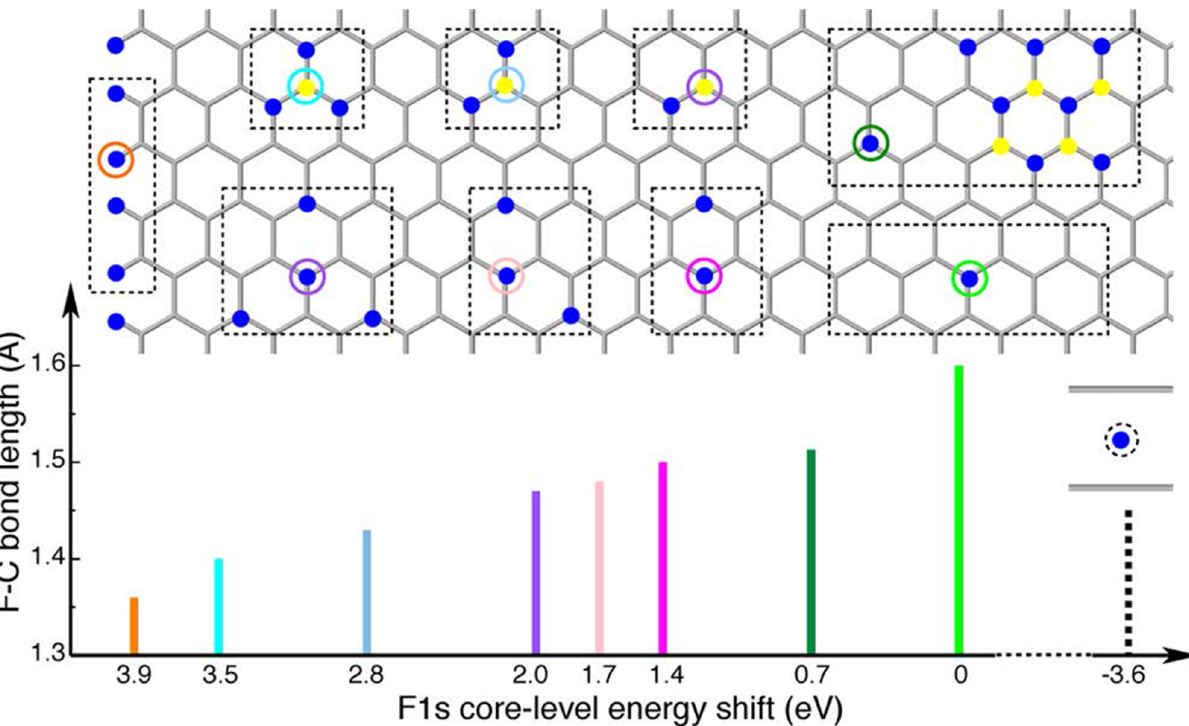
Figure 2: F-C bond length (ordinates) and F1s core-level energy shift (abscissa) of fluorine species chemisorbed on graphene in various bonding environments. From left to right, F bonded to edge C atoms of an armchair-type graphene edge, energetically most stable F-C tetramers, trimers, and dimers, and an individual fluorine species chemisorbed on a pristine region of graphene (bottom) and nearby a tightly packed agglomerate of F-C bonds on graphene (top). The color (dash) and the number of the vertical segments and open circles are used to establish the correspondence between core-level energy shift and the fluorine species drawn in the ball-and-stick illustration. The height of the vertical segments is used to show the length of the F-C bonds in the various bonding environments. The F1s core-level binding energies calculated from DFT are referred to that as F in single F-C species (8) chemisorbed on a pristine region of graphene. The core-level energy shift of an F anion in bilayer graphene is also reported on the right (vertical dashed segment). Reprinted with permission from